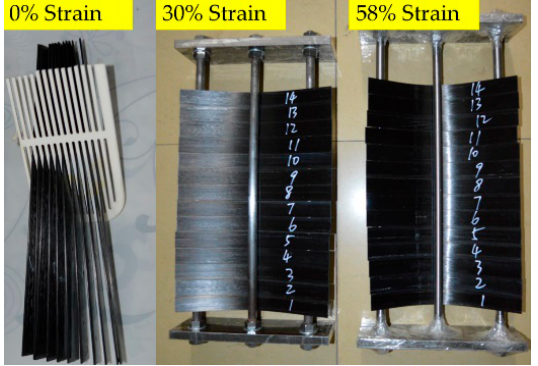
Figure 2. CFRPs under sustained 0%, 30%, and 58% bending strains, respectively. Note, the